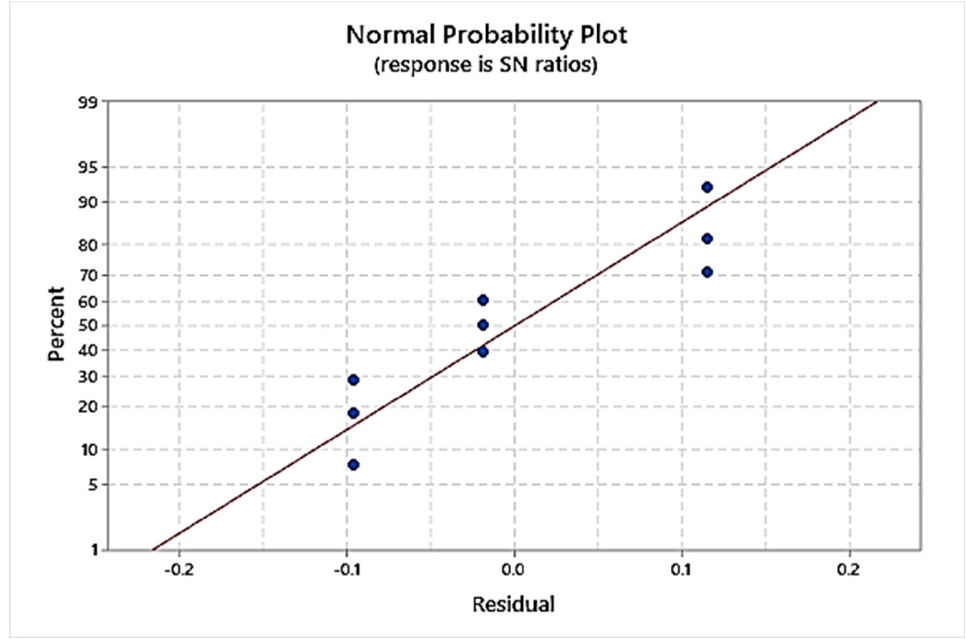
Figure 7. Normal probability plot for PLA samples under compression testing.